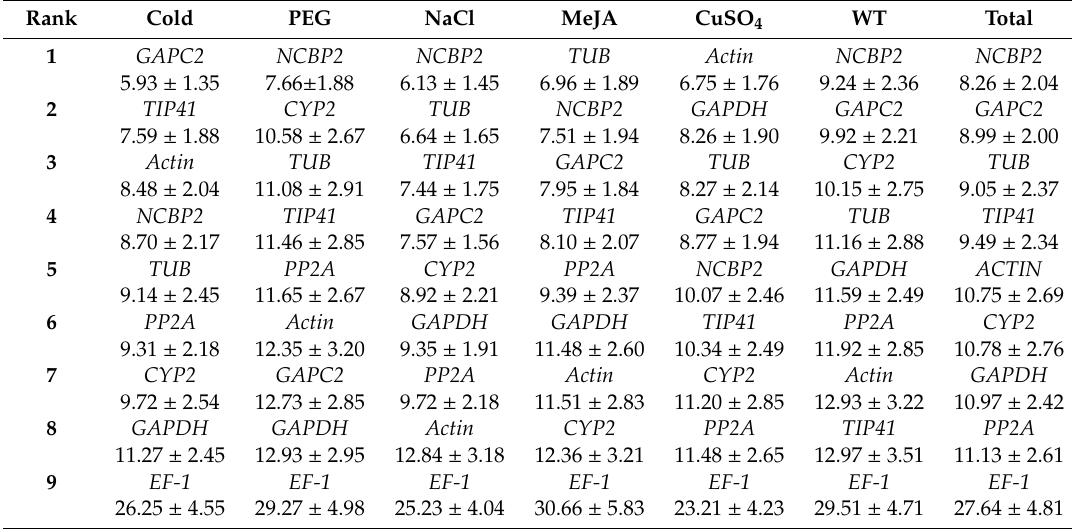
Table 2. Expression stability rank of nine candidate genes by BestKeeper software (coe ffi cient of variance (CV) ± standard deviation